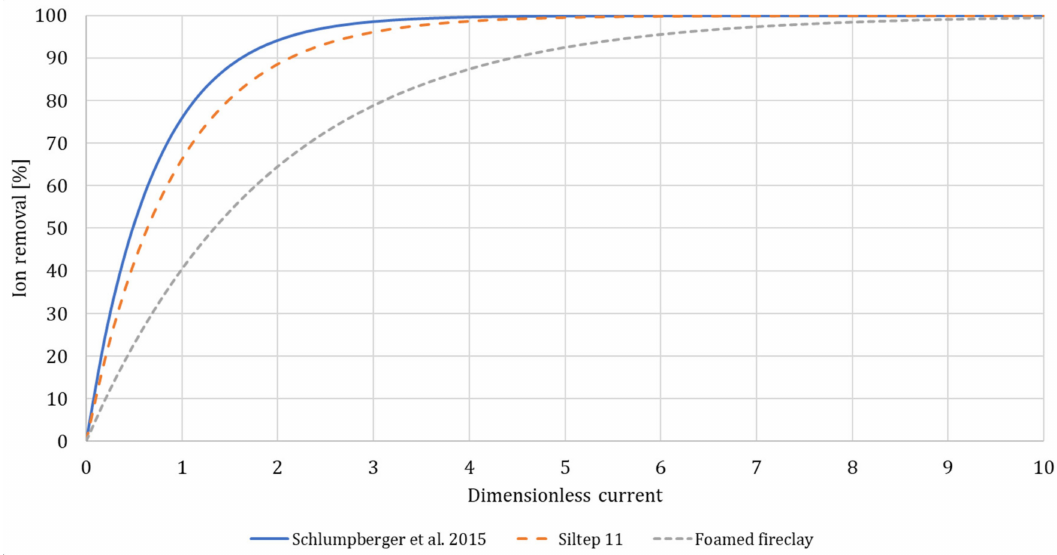
Figure 7. Comparison of performance of our unit with various installed porous media and AMEs and reference units with silica glass frit and cation-exchange membranes (CEMs) using the model (4) to fit the